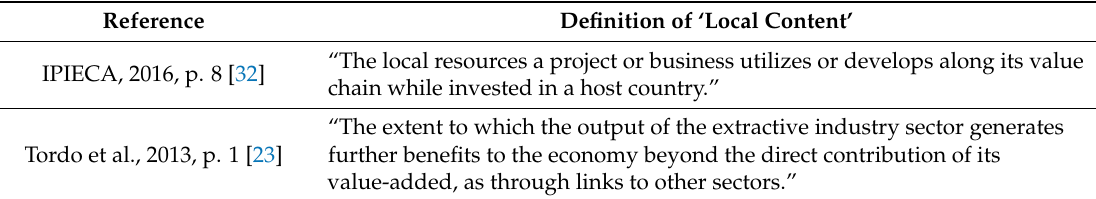
Table 1. Definitions of ‘local content’.